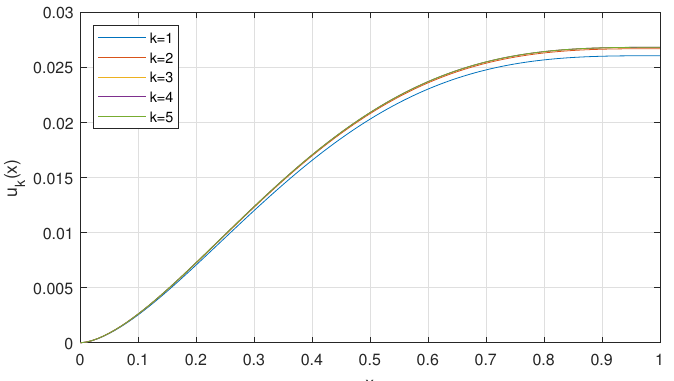
Figure 5. The approximation of the solution of problem